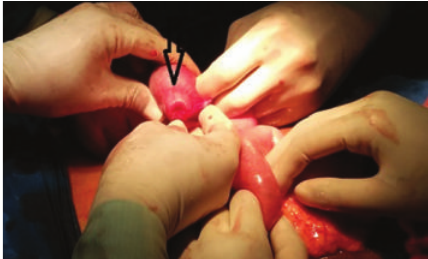
Figure 3: Invagination and depression of the serosal surface overlying the pathological lead point.